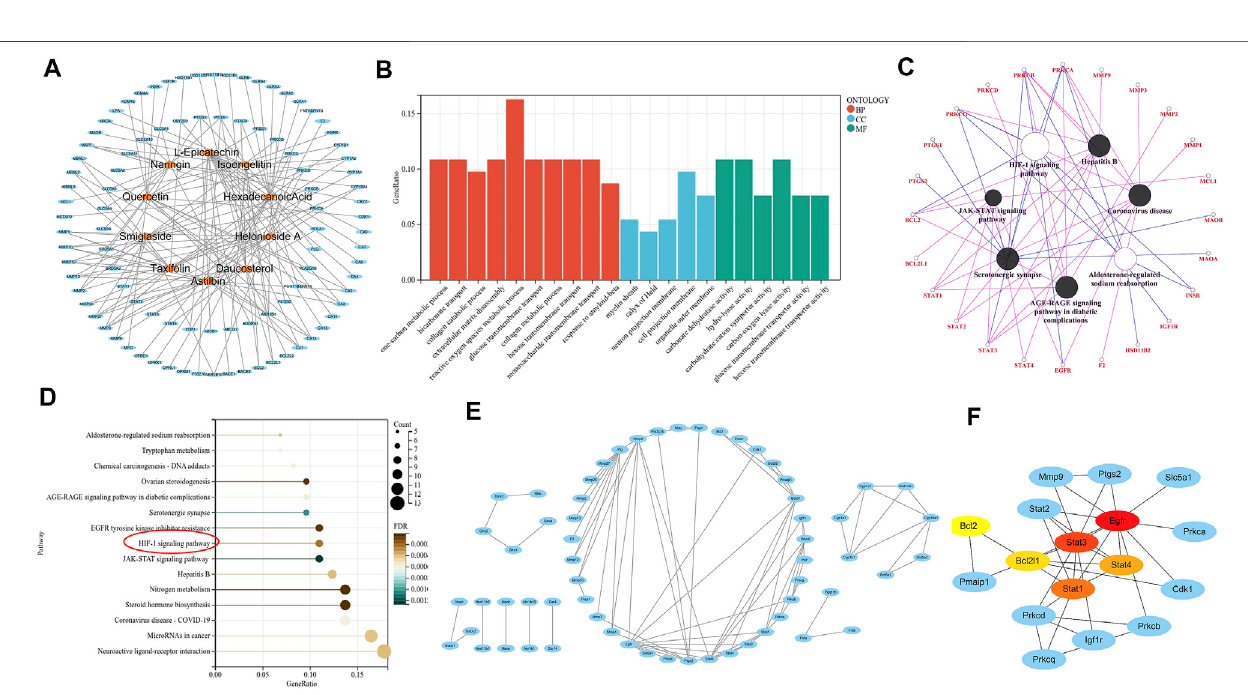
FIGURE 5 | Pharmacologic analysis showed that SGR-EA functions through the HIF-1 signaling pathway. (A) SGR-EA drug – target relationship diagram. (B) . For the GOanalysisoftheSGR-EA target, red represents BP, bluerepresentsCC,and green representsMF. (C,D) ClueGO and KEGG pathway enrichmentanalyses ofthe SGR-EAtargetsrevealedthattheHIF-1signalingpathwaymayplayanimportantrole. (E,F) ProteininteractionnetworkanalysiswasperformedonSGR-EAtargets,and Cytohubba was used to screen Stat3 as the core of the protein network. The redder the color, the stronger the gene association was.